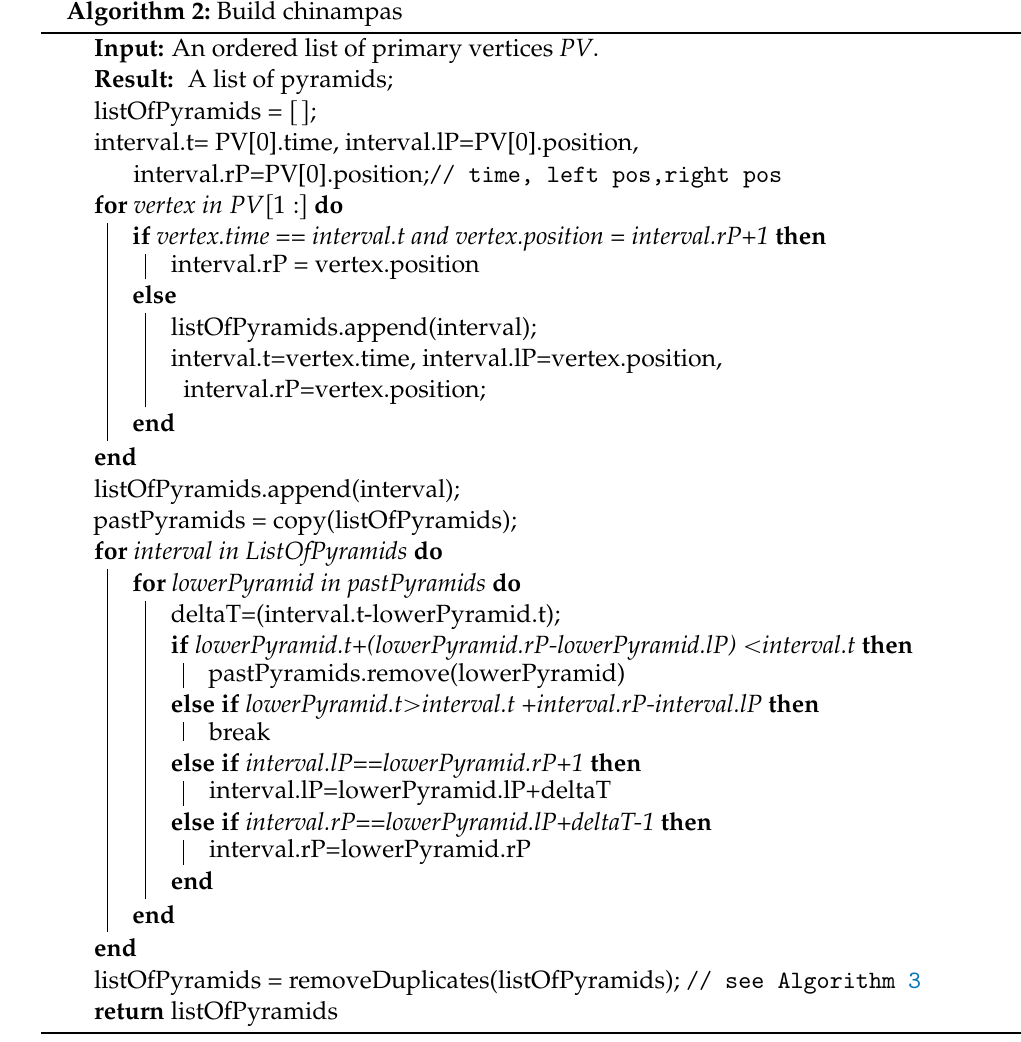
Algorithm 2: Build chinampas